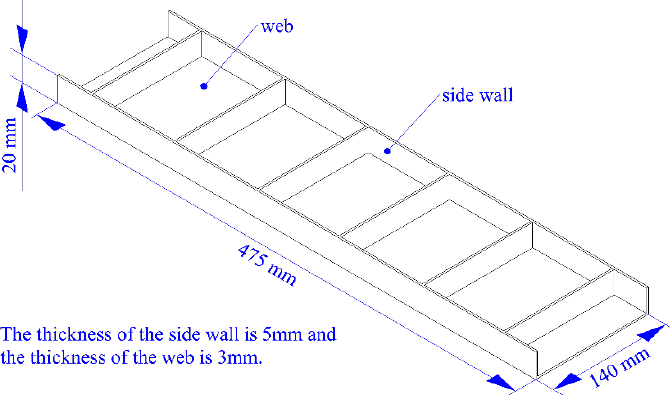
Figure 8. The structure and size of the thin-walled beam.